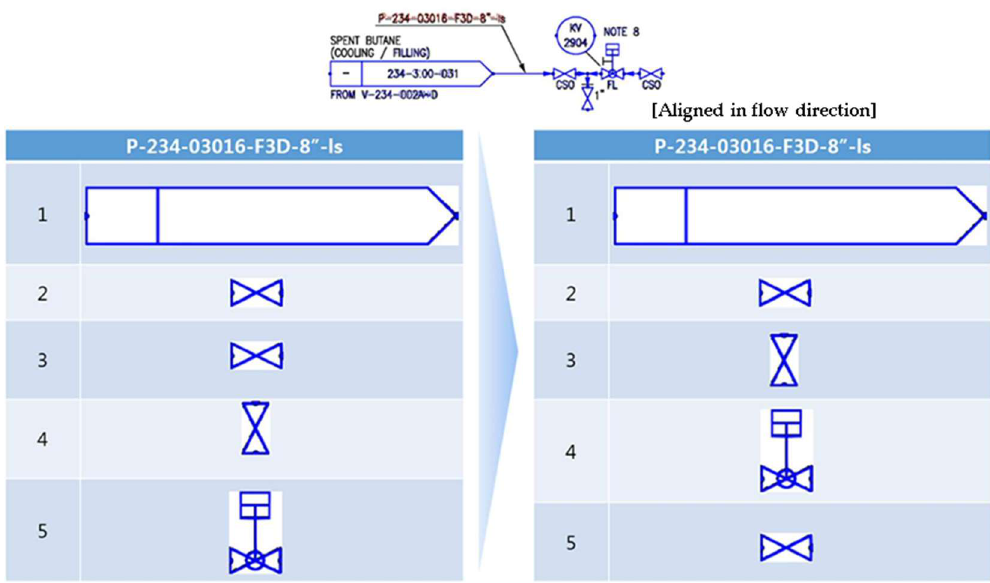
Figure 6. Sorting the order of symbol connection by flow direction.